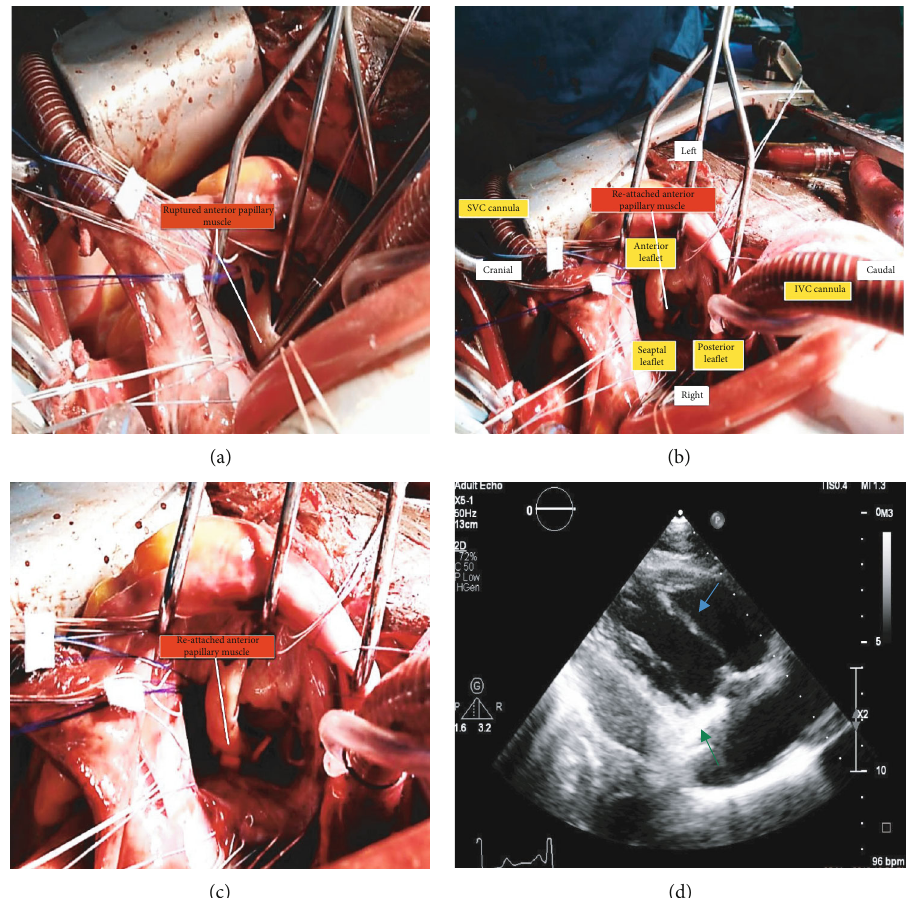
Figure 6: (a – c) Intraoperative images of ruptured anterior papillary muscle and its repair and (d) transthoracic postoperative right ventricular in fl ow view showing the repaired anterior papillary muscle (blue arrow) and annuloplasty ring (orange